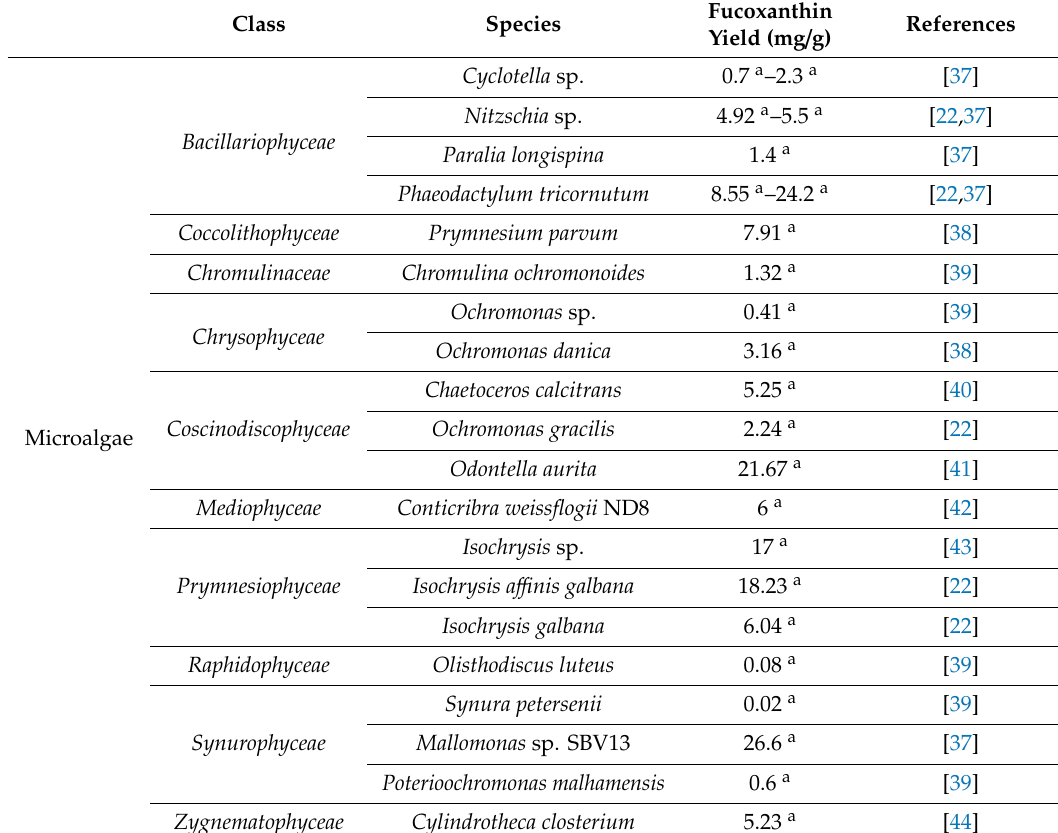
Eisenia bicyclis